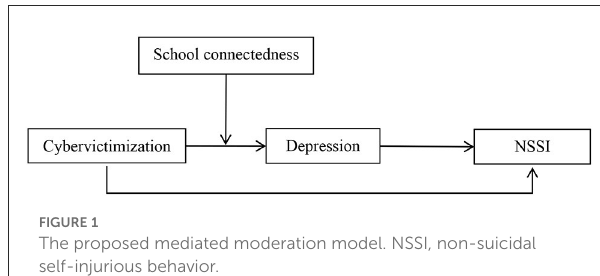
FIGURE1 The proposed mediated moderation model. NSSI, non-suicidal self-injurious